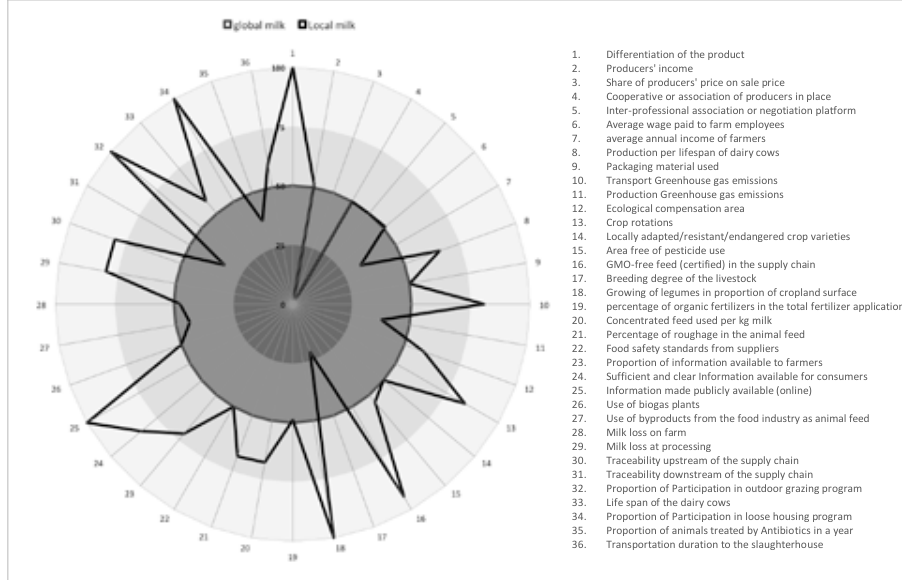
Figure 3. Performance of the local chain compared to the global chain.